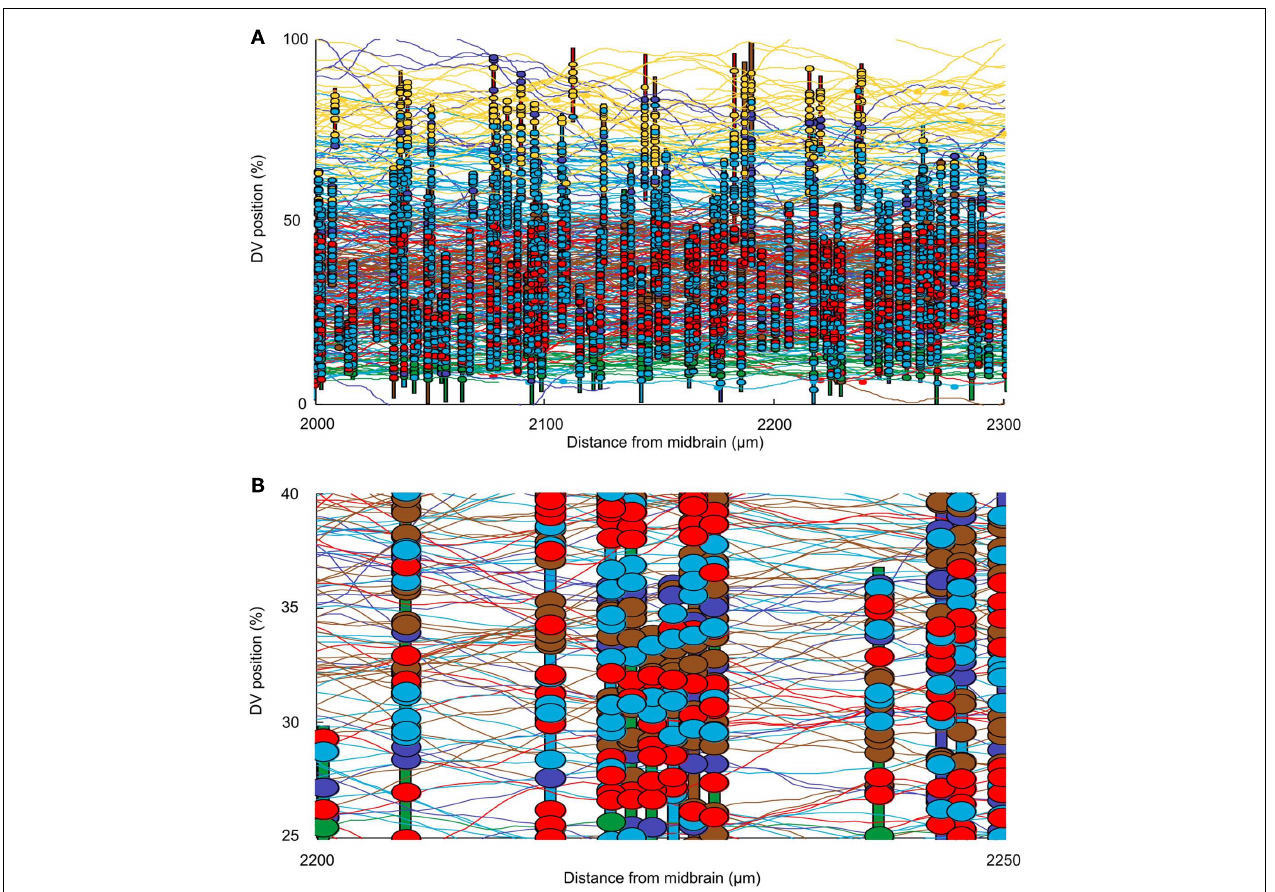
trajectories of grown axons. Dendrites and axons are color coded for cell type as in Figure 1 . Small colored ellipses indicate individual synaptic contacts. In each case, the contact is color coded according to the presynaptic cell type. (B) A small fragment of one side of the connectome, color coded as in (A)